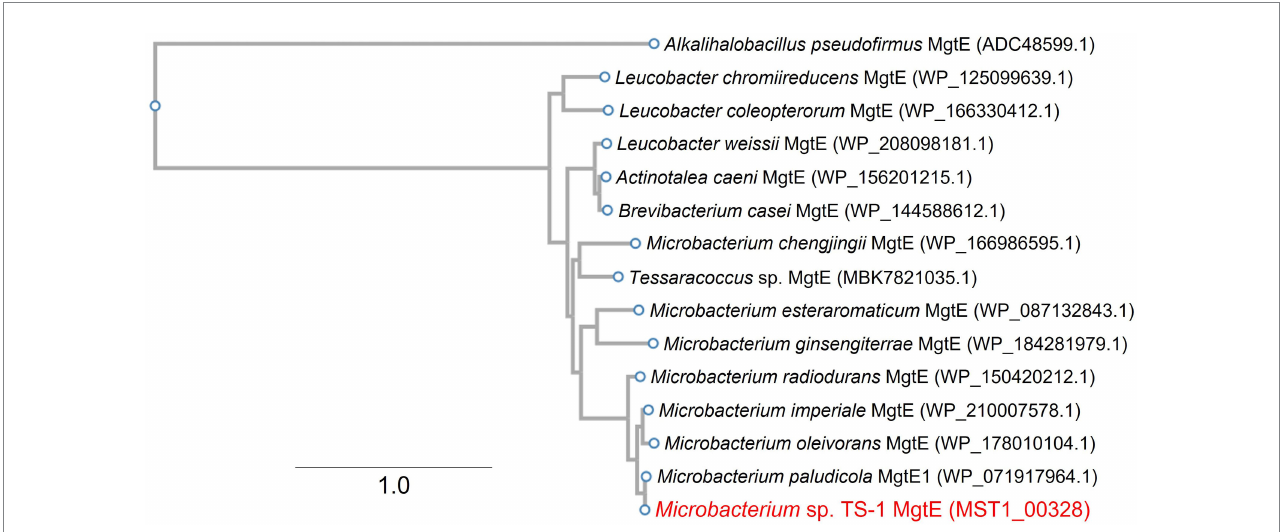
FIGURE 2 Phylogenetic clustering of MTS1_00328. A phylogenetic tree was constructed based on multiple sequence alignment with MTS1_00328 homolog. Details of this procedure are described in Materials and Methods. MTS1_00328 from Microbacterium sp. TS-1 is shown in red. MgtE from gram-positive alkaliphile Alkalihalobacillus pseudofirmus was used as an outgroup. The number between branches indicates the bootstrap value. GenBank accession Nos. are provided in